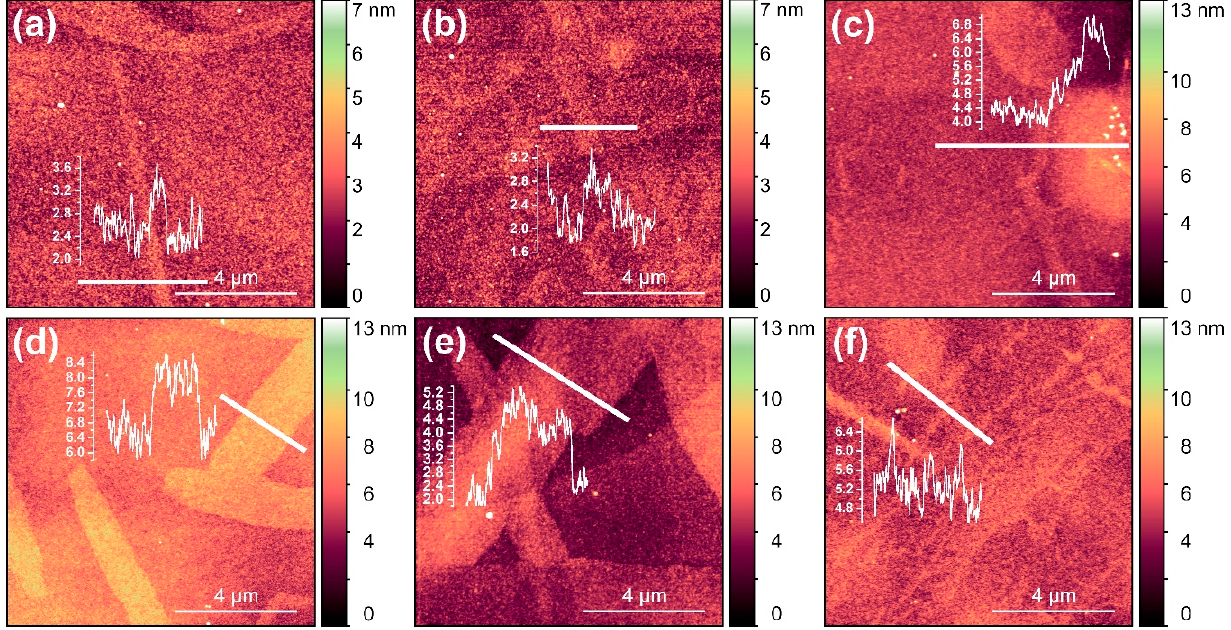
Figure 8. AFM-resolved surface topography of as-grown ε / κ -Ga2O3 films ( a ) and the films subjected to annealing at 800 °C for 10 min ( b ), 30 min ( c ), and 70 min, ( d ) and at 900 °C for 10 min ( e ) and 30 min ( f ) cumulative time. The insets show the AFM scans along the solid white lines.